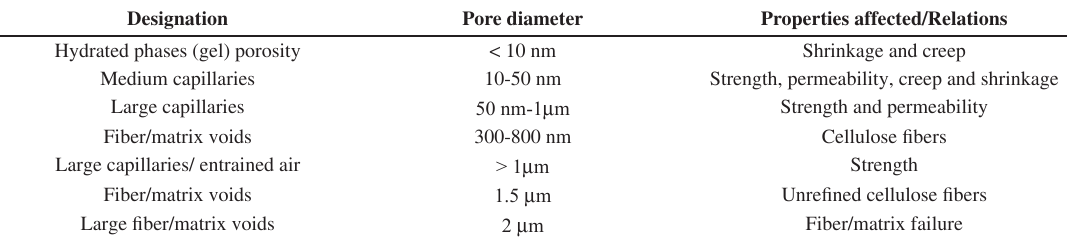
Table 8. Classification of pore size in hydrated cement paste/fiber